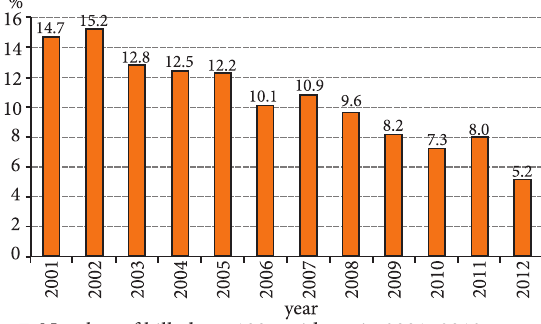
Fig. 7. Number of killed per 100 accidents in